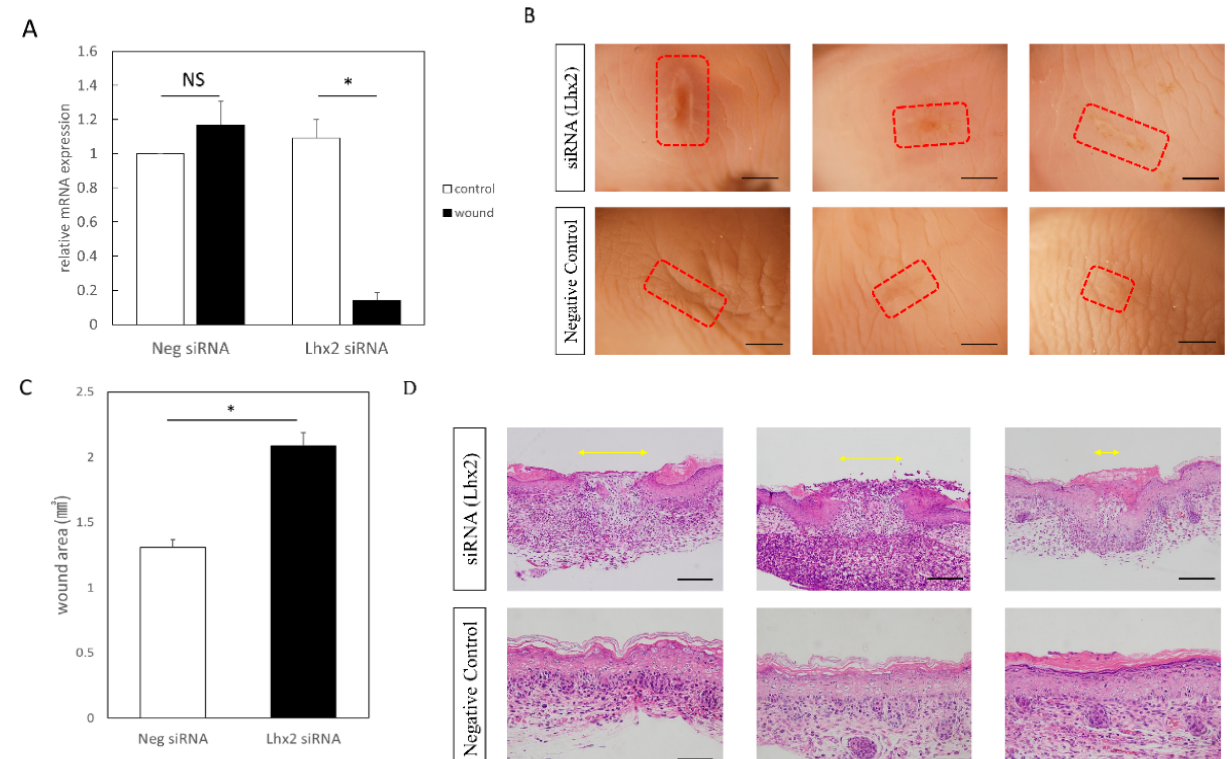
Figure 3. Effect of Lhx2 knockdown on fetal wound healing. ( A ) siRNA-mediated Lhx2 knockdown. Lhx2 expression was significantly suppressed in the Lhx2 siRNA group. ( B ) Macrograph of the scar, Bar = 500 μ m. ( C ) Comparison of the area of the scar, which was significantly large in the Lhx2 siRNA group. ( D ) H-E stained image of the wound. In the Lhx2 siRNA group, wounds were inadequately epithelialized (yellow arrows). Additionally, loss of hair follicles is observed. * p < 0.05. NS: non-significant. Scale bar = 100 μ m.